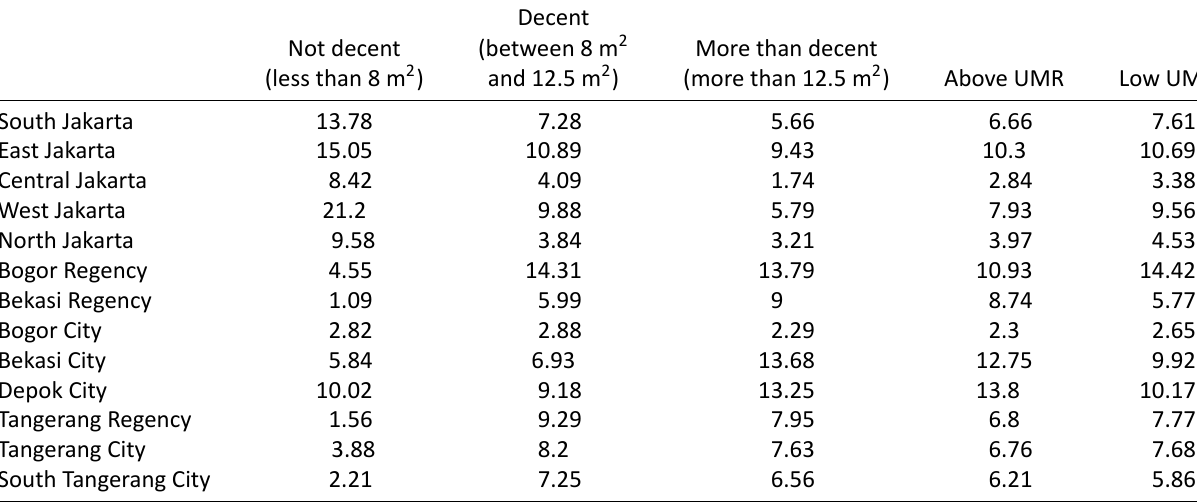
Table 3. Salary range proportion (%) and area of residents (m 2 ), by residential districts.